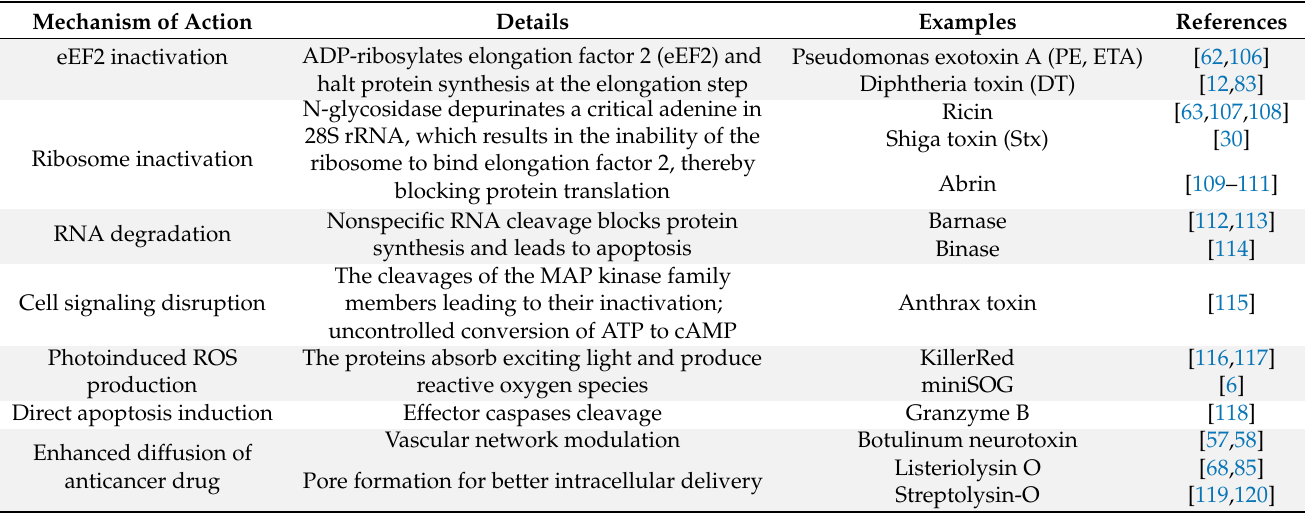
Table 1. Protein moieties commonly used in experimental anticancer